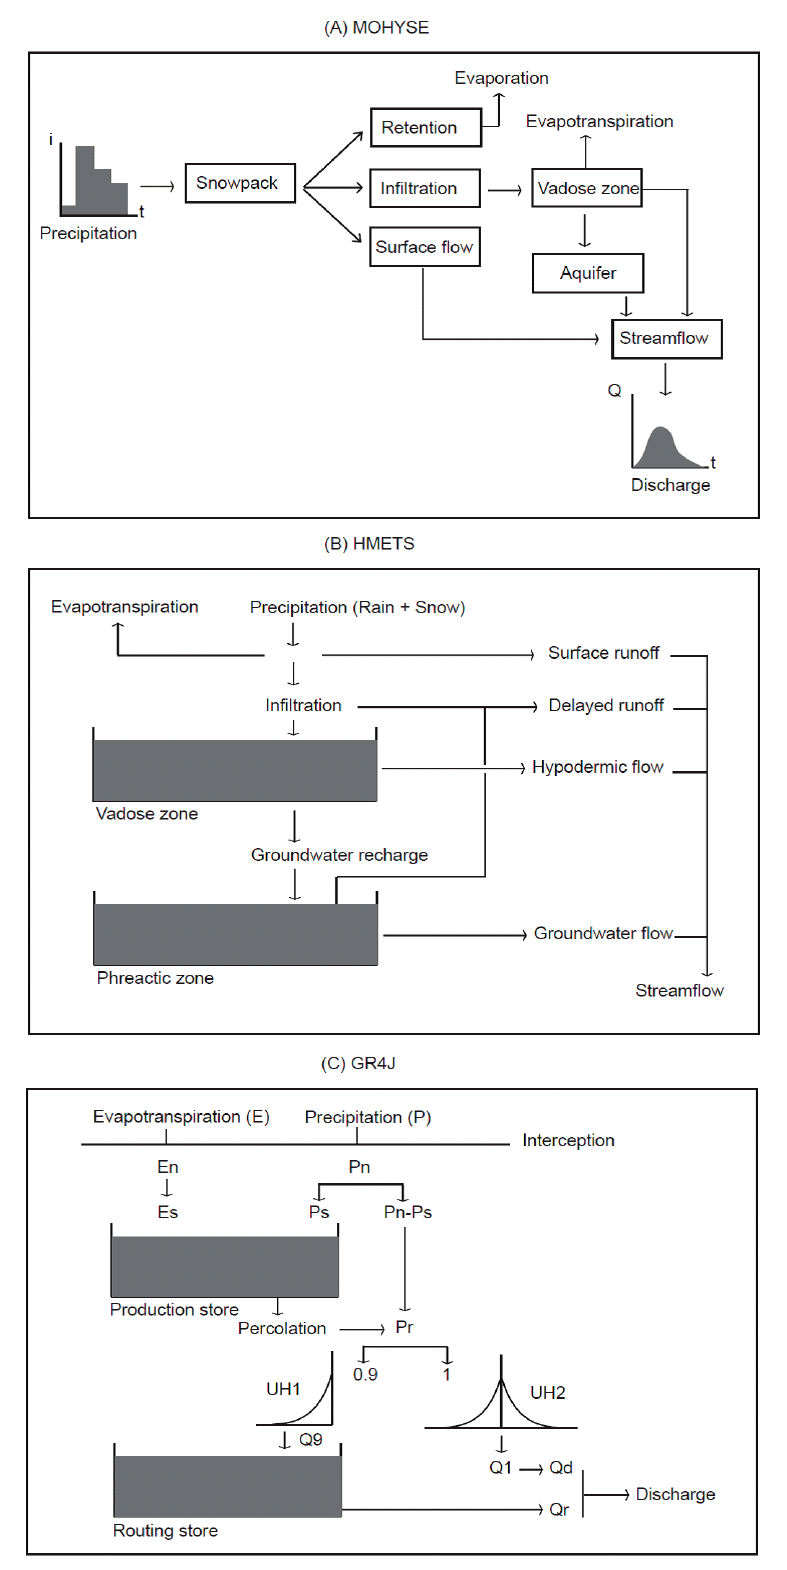
Figure 4. Structure of the ( A ) MOHYSE; ( B ) HMETS; and ( C ) GR4J